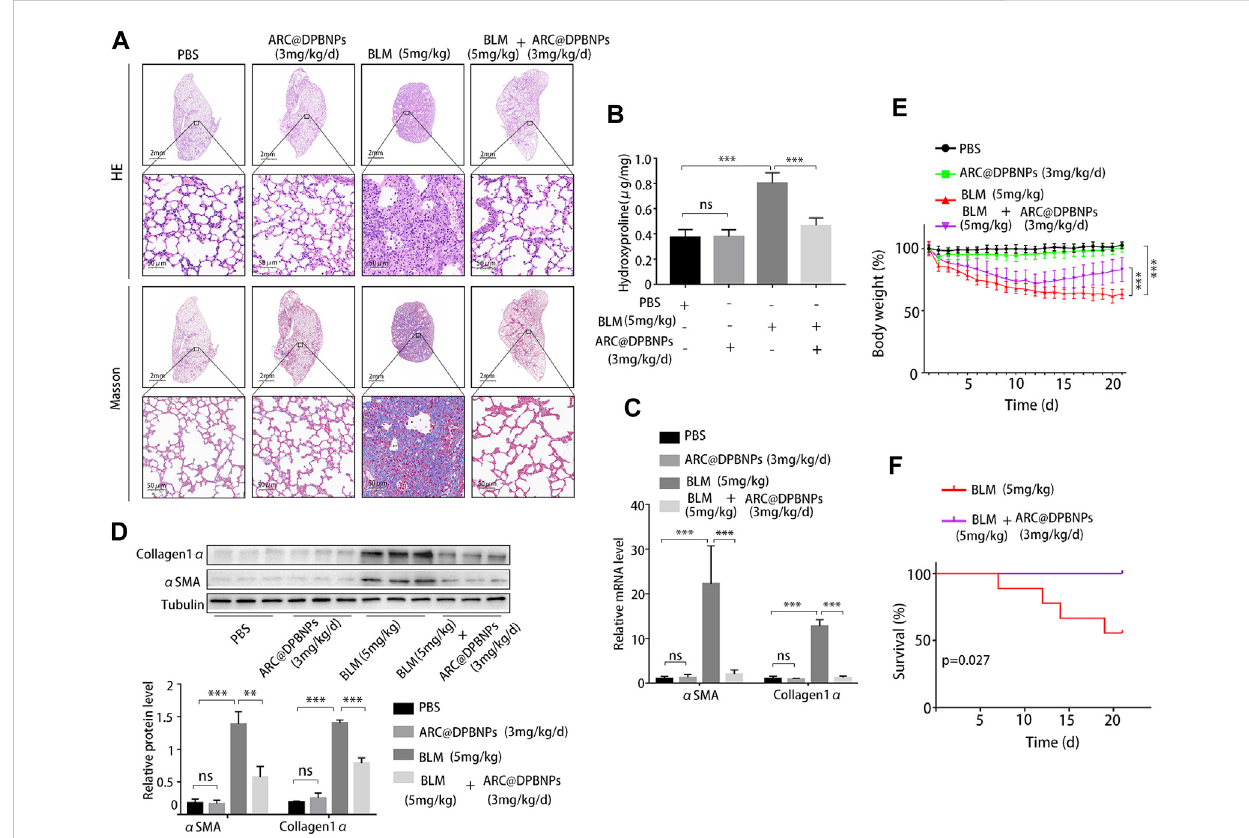
FIGURE 9 Arctiin-encapsulatedDSPE-PEGbubble-likenanoparticle(ARC@DPBNP)treatmentsigni fi cantlyalleviatedpathologicalchangesandimprovedtheoutcome ofthebleomycin(BLM)mousemodel. (A) Typicalimagesoflungsectionswithhematoxylin – eosinandMasson ’ strichromestainingshowingthatARC@DPBNPs (3 mg/kg/d) signi fi cantly alleviated the disturbed pulmonary structure of the BLM-induced pulmonary fi brosis mouse model. No excessive pulmonary damage wasobserved. (B) Hydroxyprolinecontentinthemouselungswasmeasuredonday21. (C) RelativemRNAexpressionand (D) relativeproteinlevelsoflung fi brosis markers ( α -SMA and collagen1 α ) in the lungs of mouse models on day 21. (E) Body weight was measured daily, and the variations (in grams) from the starting point are shown. (F) Survival curve of the BLM and BLM + ARC@DPBNP groups ( n = 9 for each group). * p < 0.05, ** p < 0.01, *** p <